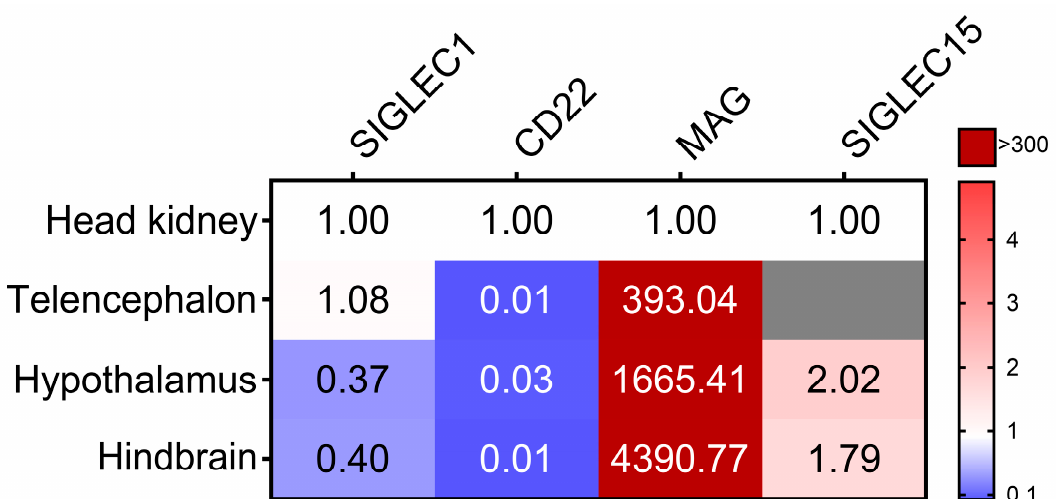
Figure 2. Expression of Siglec1 , CD22 , MAG , and Siglec15 in the di ff erent brain regions of maraena whitefish. The qPCR data were normalized by the reference genes RPL9 , EEF1A1b , and RPL32 . The resulting transcript numbers of the same genes in di ff erent brain regions are shown relative to the respective transcript levels in the HKs, which were set at 1.0. Transcript values compared with those found in HKs are colored according to the code on the right. Non-detectable transcript numbers are indicated by a gray